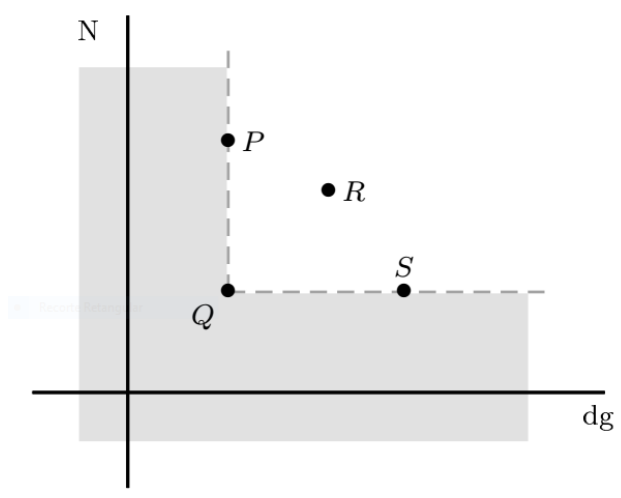
Figure 1. Graphical representation of potential frontier points in the objective space (dg, N).